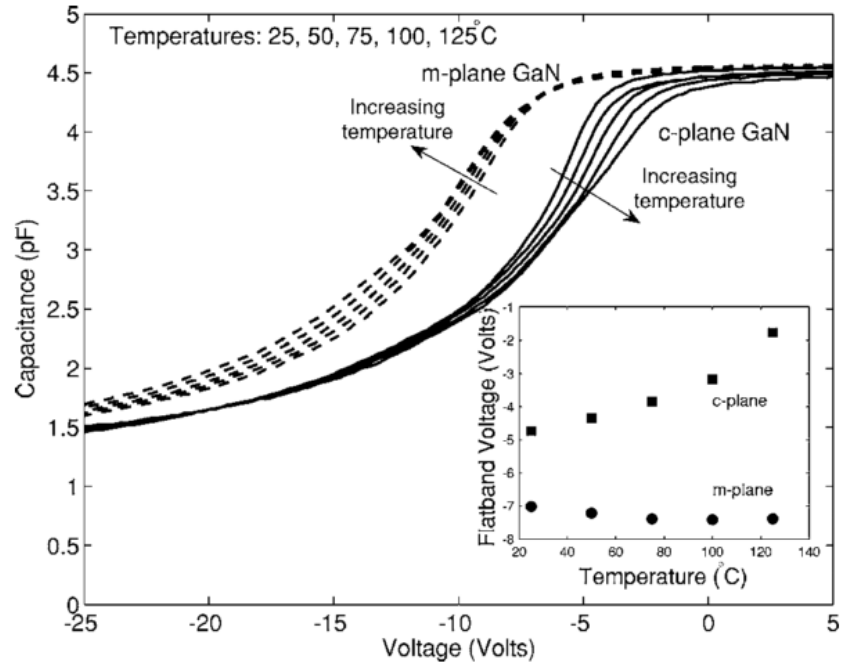
Figure 9. Examination of the pyroelectric effect on the capacitance voltage (CV) profile of GaN based devices [88]. Reprinted with permission from reference 88. Copyright (2007) by the American Institute of